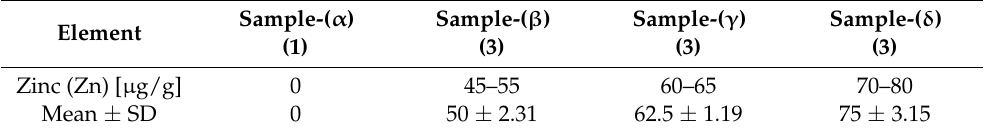
Table 1. Prepared standard samples of P. harmala seeds using zinc as dopant material in µ g/g.